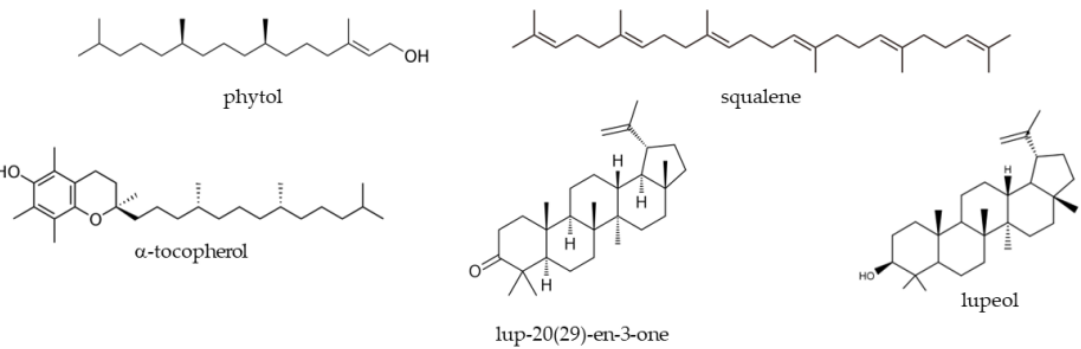
Figure 3. Chemical structures of phytol, squalene, α -tocopherol, lupenone (lup-20(29)-en-3-one), and lupeol.